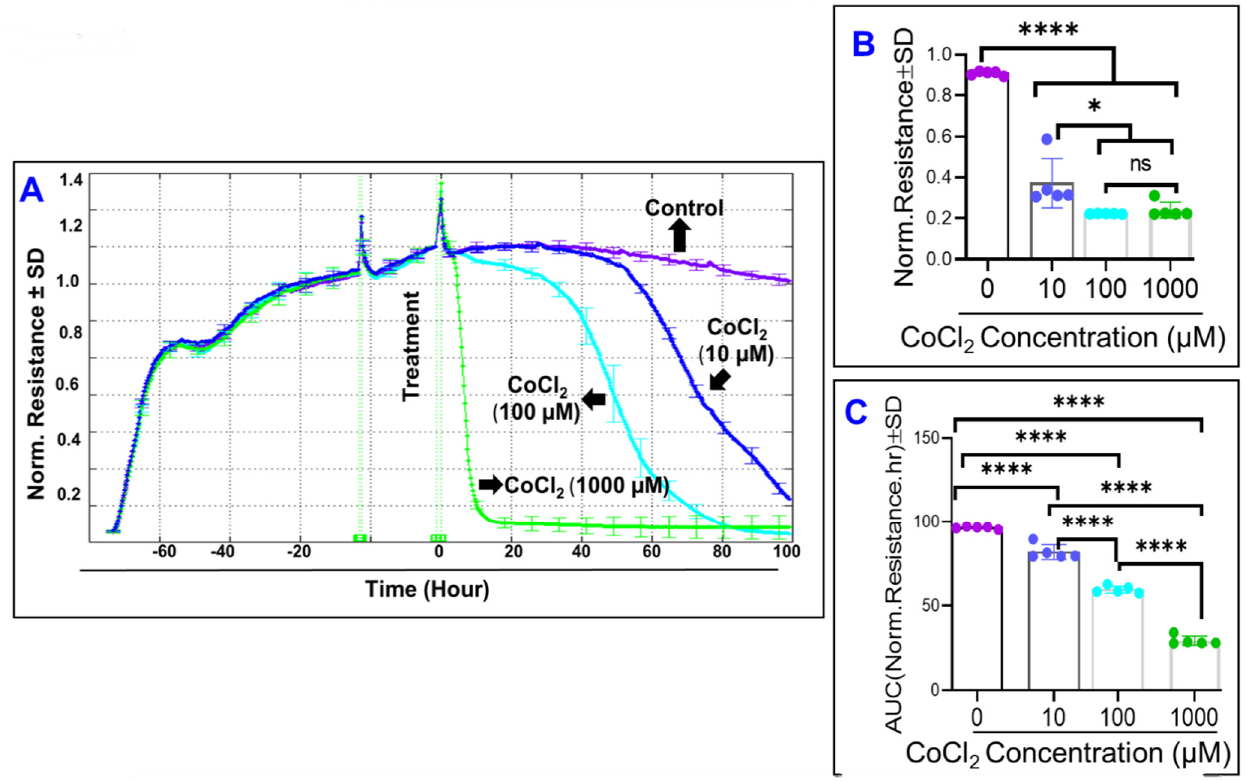
Figure 4. Real-time monitoring of ARPE-19 total resistance under cytopathic hypoxia. ( A ) Normalized Resistance of the ARPE-19 cell groups vs. time, measured at an AC current frequency of 4000 Hz. Treatments applied at T = 0. Resistance measured from time of placement onto ECIS electrode to 100 h after treatment application. ARPE-19 cell groups were a control, 10 µM CoCl 2 treatment, 100 µM CoCl 2 treatment, and 1000 µM CoCl 2 treatment groups. ( B ) Bar chart representation of each group’s normalized resistance at end of experiment T = 100. Using an end-point comparison, the 100 µM group and 1000 µM group display no difference between themselves. ( C ) Bar chart representation of each group’s area under the normalized resistance curve for the interval T = 0 to T = 100 h. Using an area under the curve comparison, each of the 4 groups demonstrates a significant difference compared to each other group. Abbreviations: Norm, normalized; AUC, area under the curve; ns, no significance. Data shown are the mean ± SD of 5 independent biological replicates ( n = 5/group), p values are * p ≤ 0.05 and **** p ≤ 0.0001.